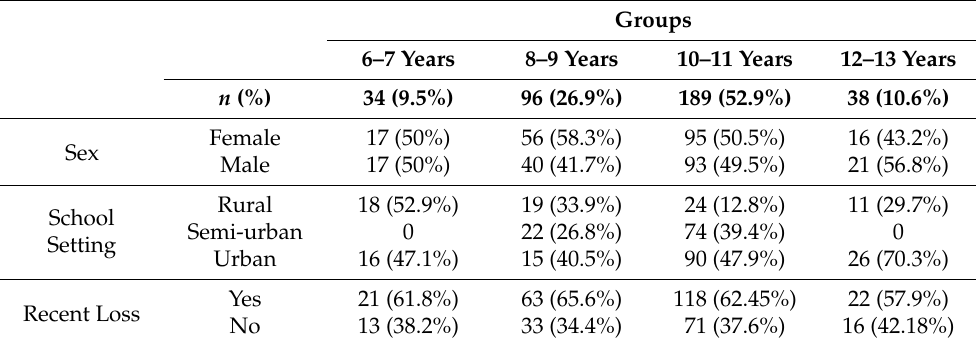
Table 2. Sociodemographic data sample divided by age